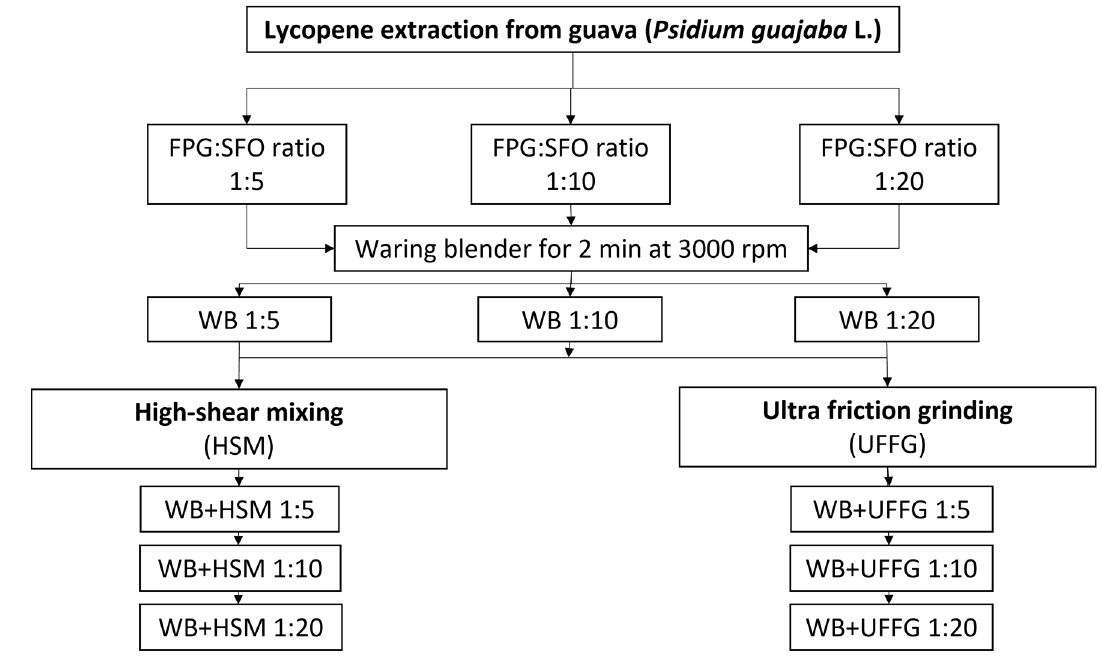
Figure 7. Scheme of the process assessed for lycopene extraction from FPG.